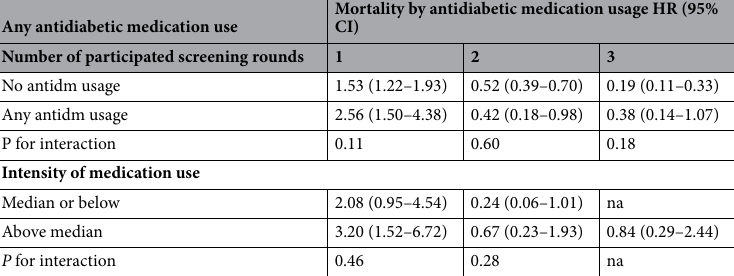
Table 5. Effect of screening on prostate cancer—specific mortality among users and non-users of antidiabetic medication. Study population of 78,615 men from the Finnish Randomized Study of Screening for Prostate